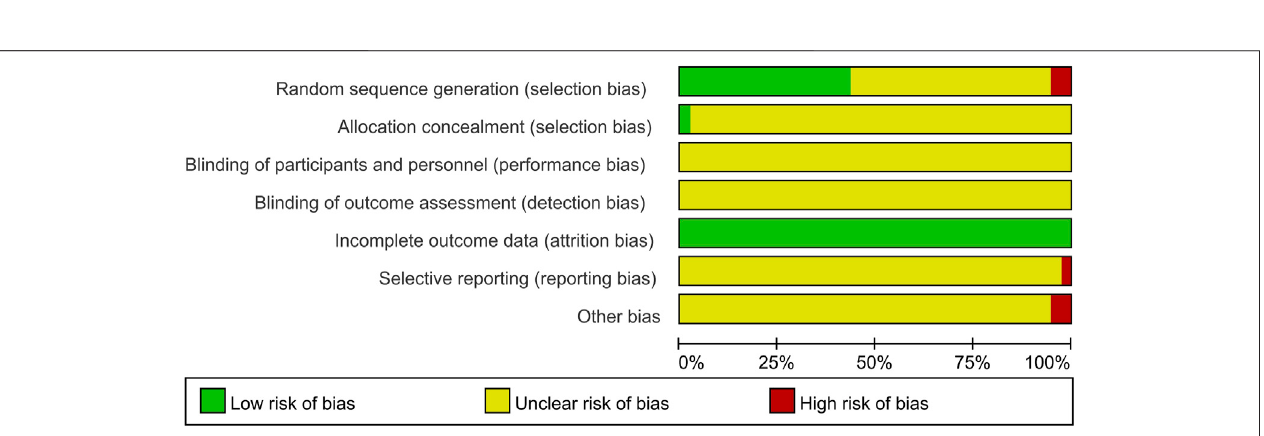
FIGURE 3 | Assessment of risk